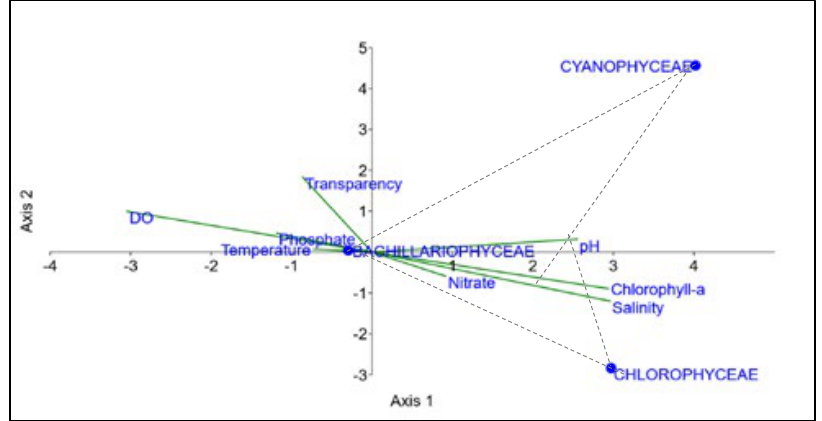
Fig. 5: CCA plot showing the relationship between the microalgal composition and environmental parameters